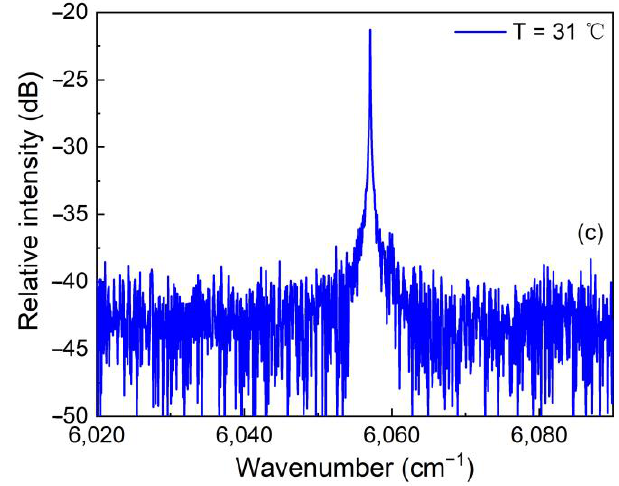
Figure 3. The output performance of the 6057.10 cm −1 CW-DFB laser. ( a ) The trend of laser output wavelength. ( b ) The laser output power. ( c ) The emission spectrum of the 6057.10 cm −1 CW-DFB laser.